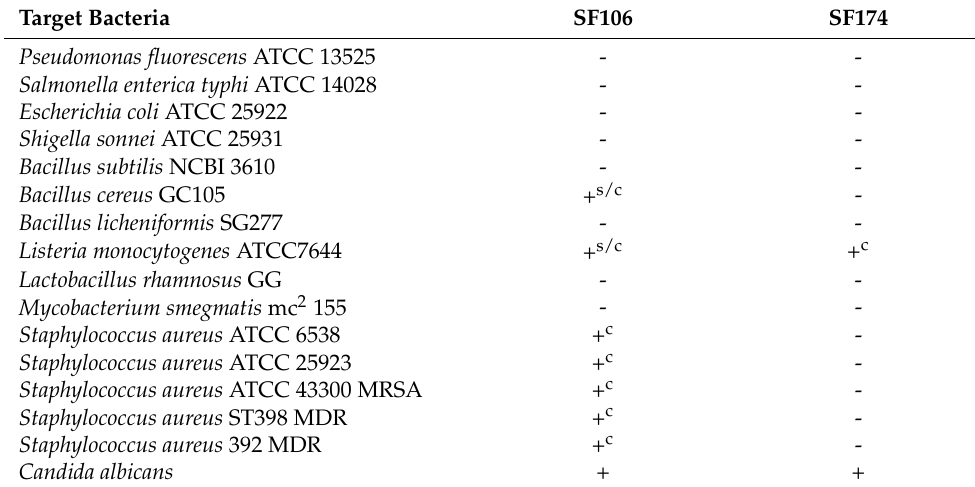
Table 4. Antimicrobial activity of SF106 and SF174 against a panel of target bacteria. Target Bacteria